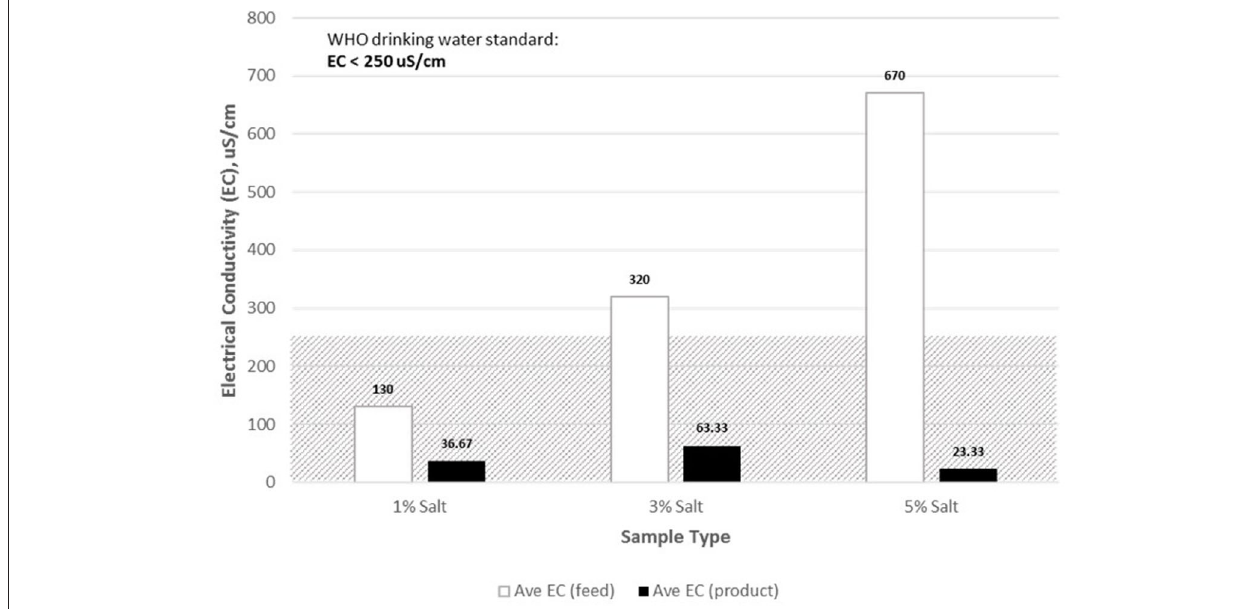
FIGURE 11 | Electrical conductivity values of feed and product water.